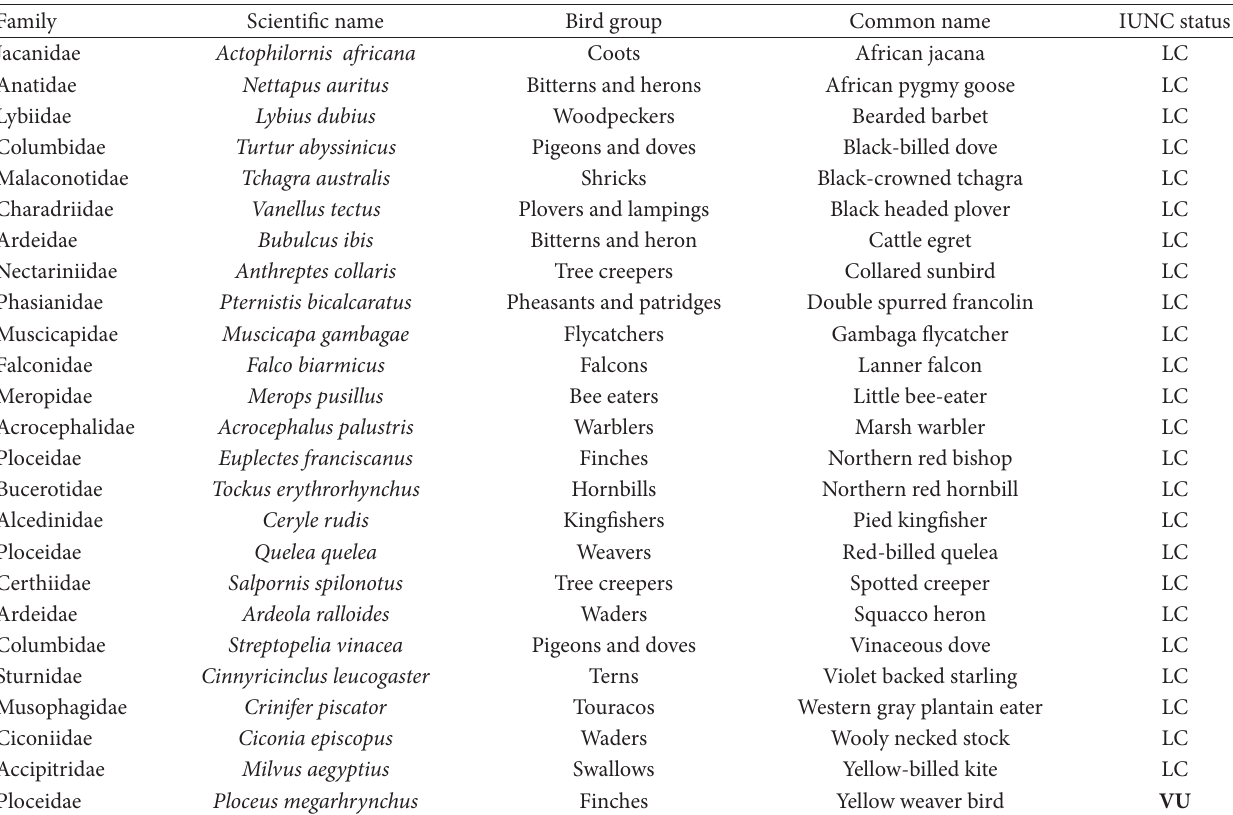
Table 1: List of bird species detected and their status, with respect to the IUCN global “ Red List ” database.